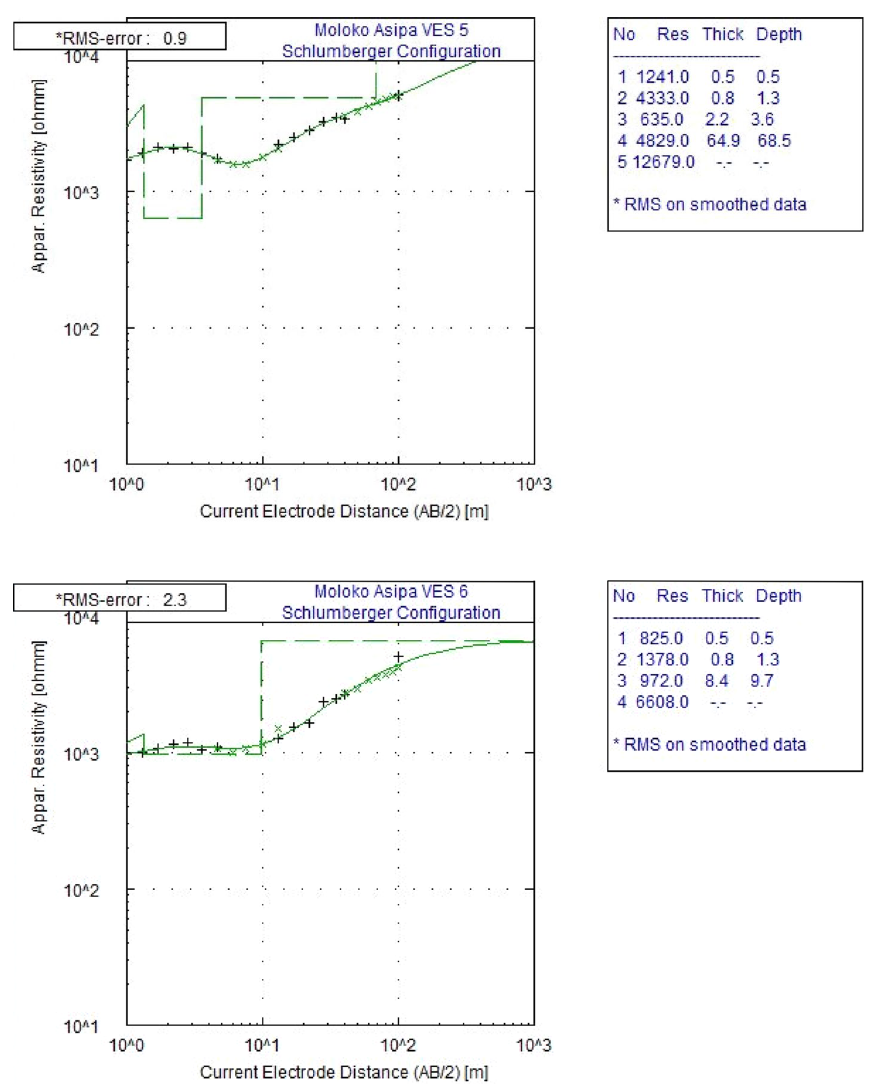
Fig. 14 Layer model interpreta- tion for VES 4